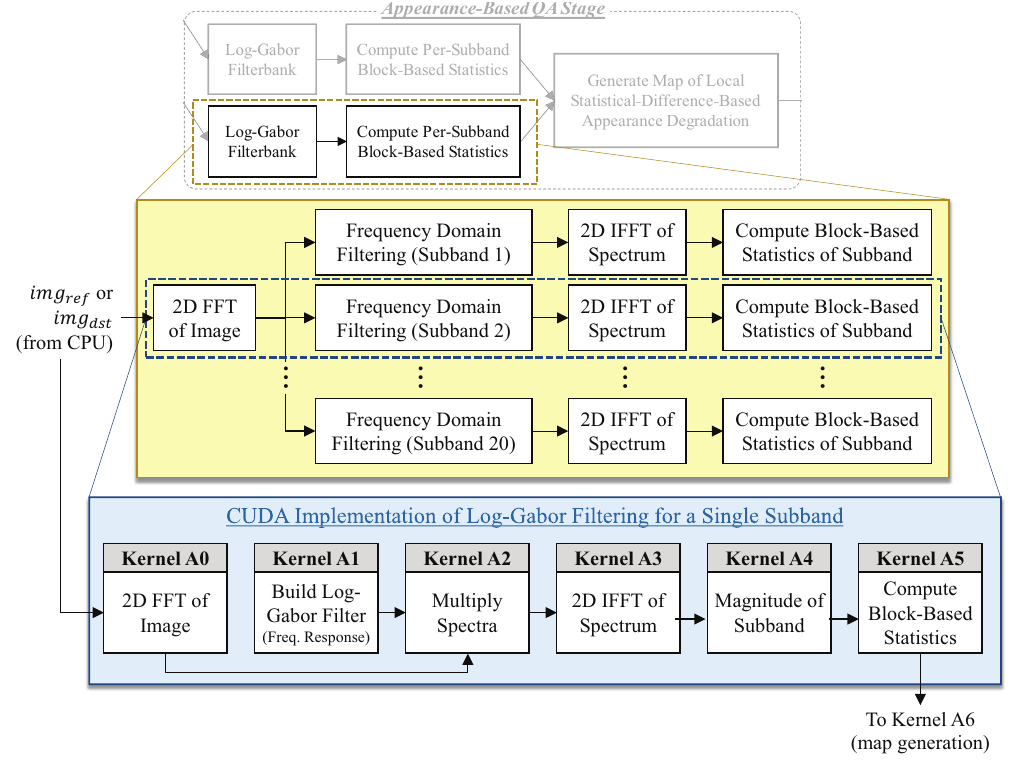
Figure 3. Block diagram of the CUDA implementation of MAD’s appearance